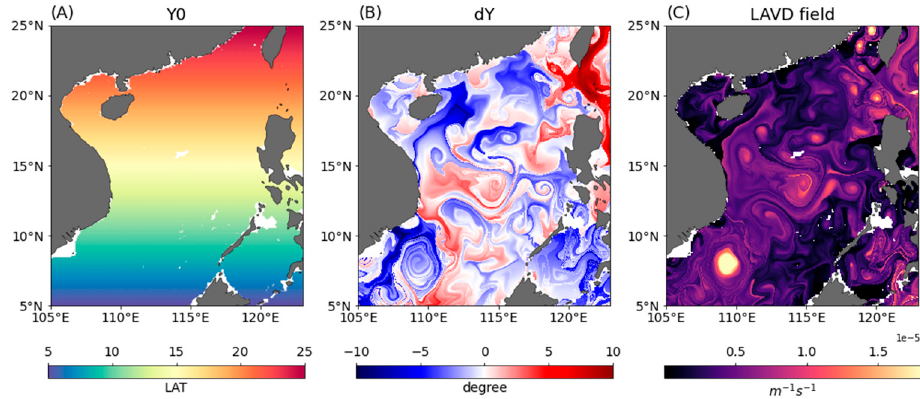
Figure 2. ( A ) The initial latitude of Lagrangian particles released around the SCS on 1 January 2006. ( B ) The meridional displacement (in degree) of these particles after 180 days. ( C ) A 30-day LAVD field.